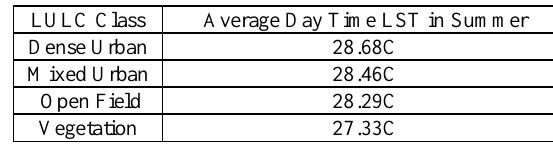
Table 3. Average LST of major LULC classes